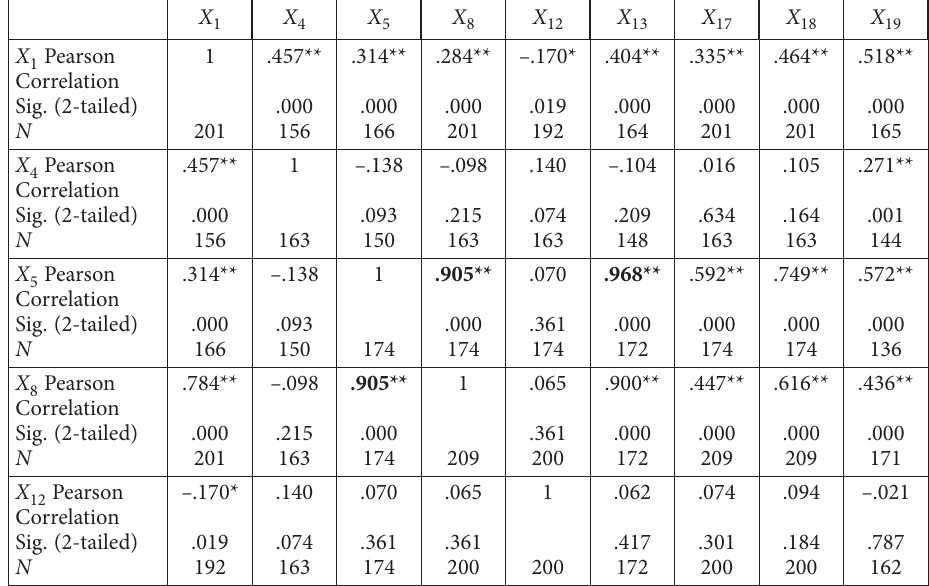
Table 3. Correlation matrix of causal